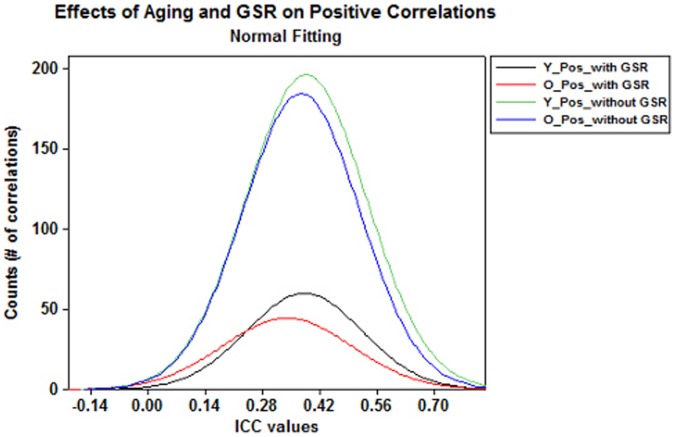
Effects of aging and GSR on positive correlations.Frequency plots of multi-scan ICCs for significant positive correlations showed pronounced decreases in positive (Pos.) correlations with aging and GSR.